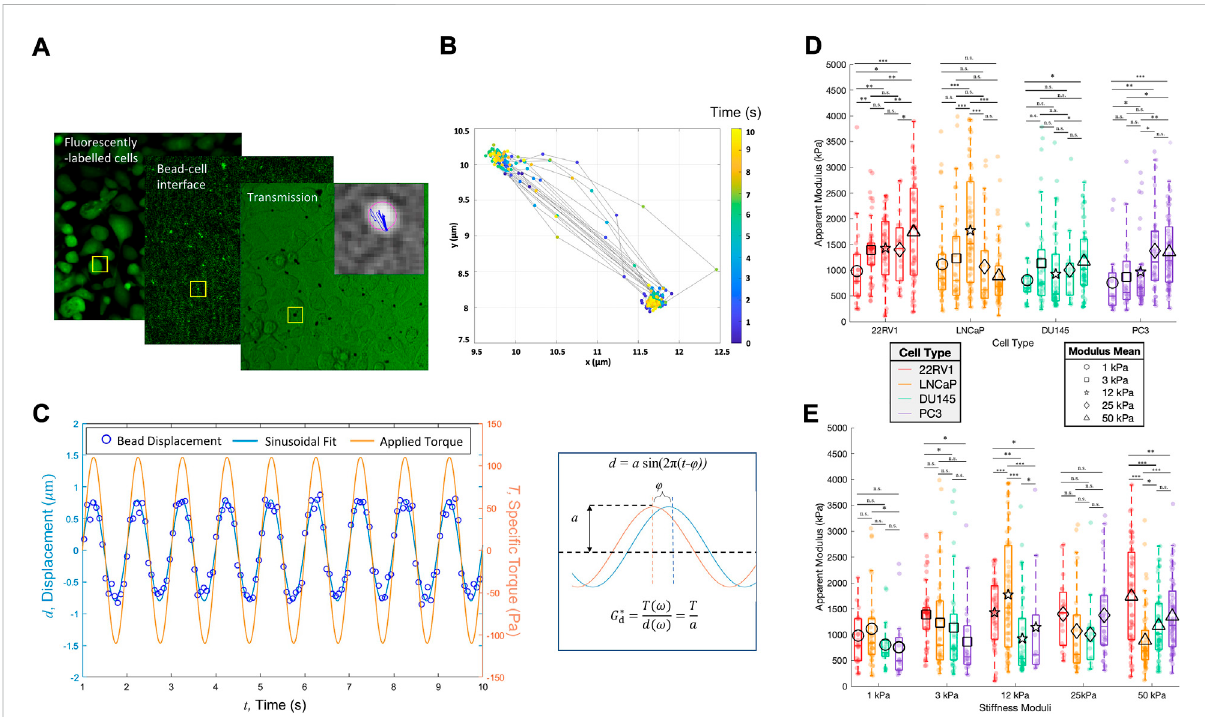
Prostate cancer cell monolayers of varying metastatic potential display diverse cell stiffness. (A) Parallelized acquisition of membrane-bound 4.5 um RGD-coated magnetic beads displaced by an oscillating applied torque. The sample shown is PC3 plated on 3 kPa. (B) Trajectories of individual beads tracked and synchronized with the applied torque, after which (C) bead displacements were fi tted to a sinusoid curve to determine the apparent cell modulus, G d *. (D) Apparent modulus measured for cell lines of increasing metastatic potential on substrates of increasing stiffness, grouped according to cell type. (E) Same data shown in A but clustered according to the substrate type. Statistics were calculated using a pairwise Mann – Whitney U test where * p < 0.1; ** p < 0.01; *** p < 0.001. Pairwise statistical comparisons across all groups for apparent cell moduli may be found in Supplementary Table